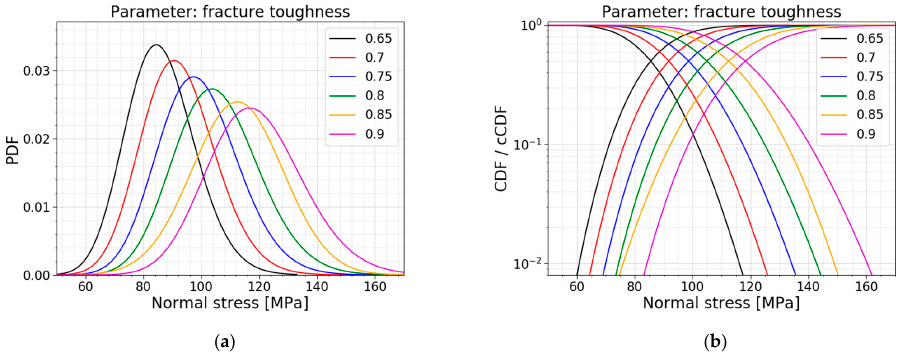
Figure 27. ( a ) PDF and ( b ) CDF for varying fracture toughness.